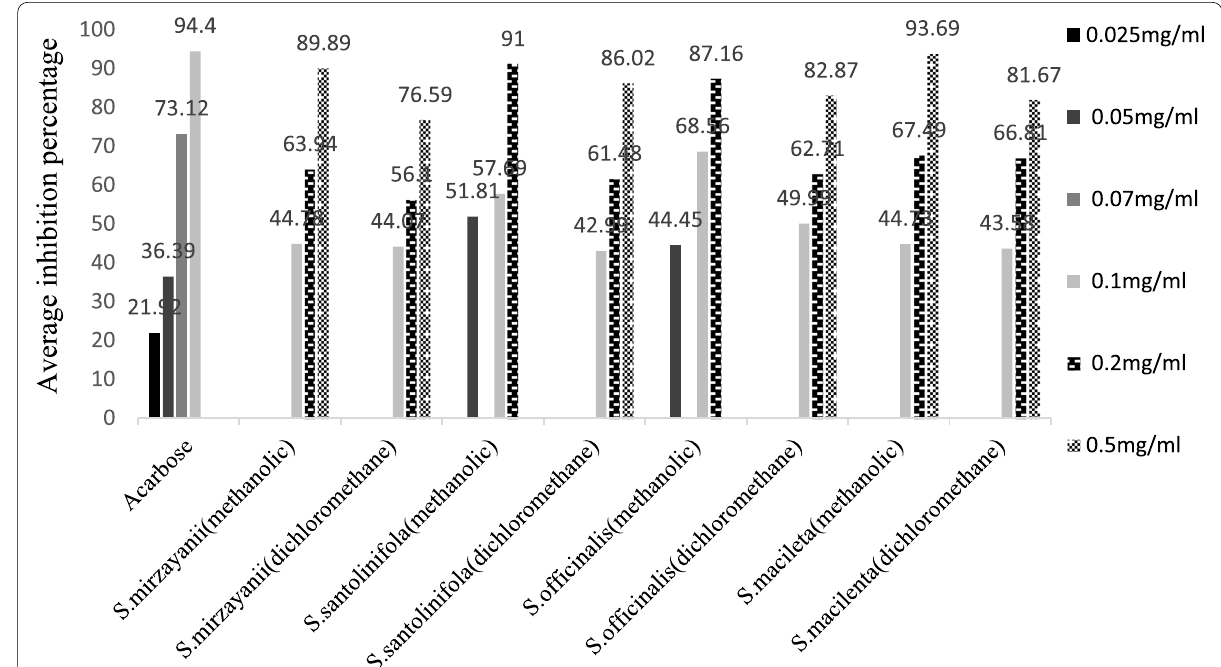
Fig. 1 Comparison of mean percentage of α-amylase inhibition by different concentrations of the extracts and